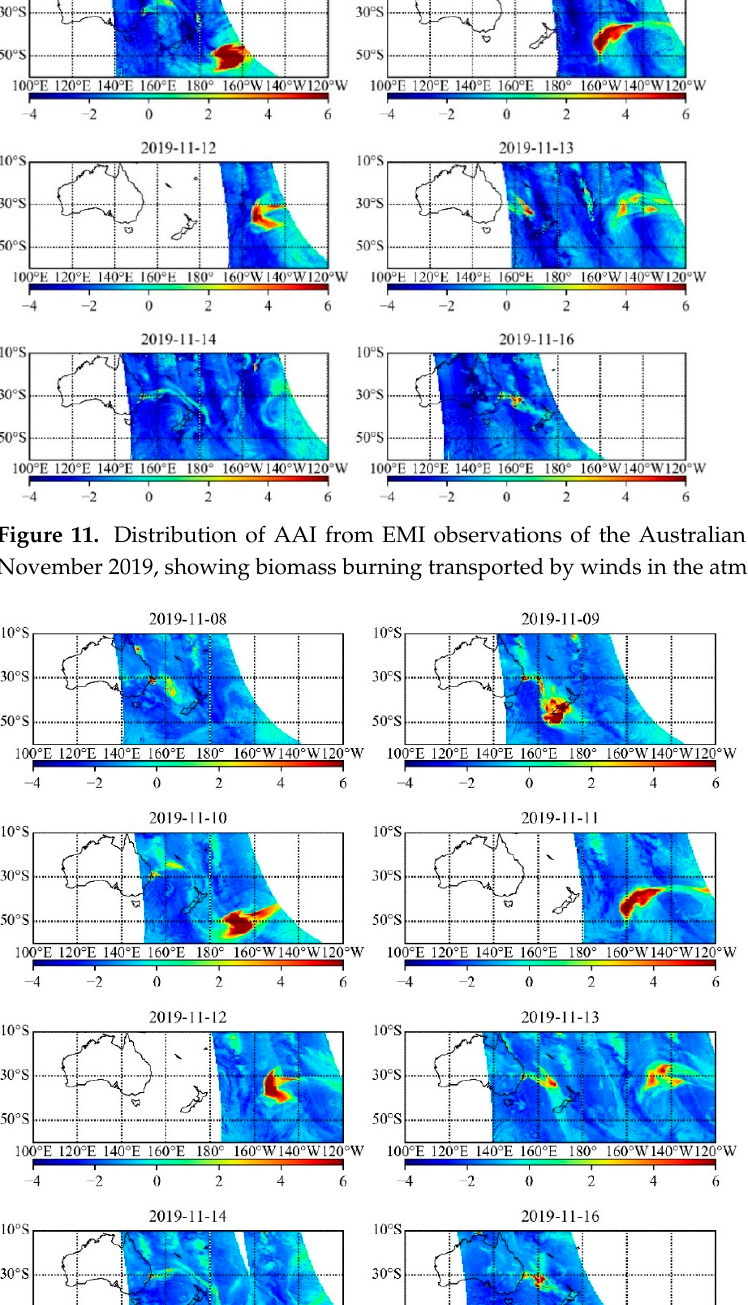
Figure 13. Comparisons of EMI and TROPOMI AAI observations on 9 (a), 10 (b), 11 (c), and 12 (d) November 2019.